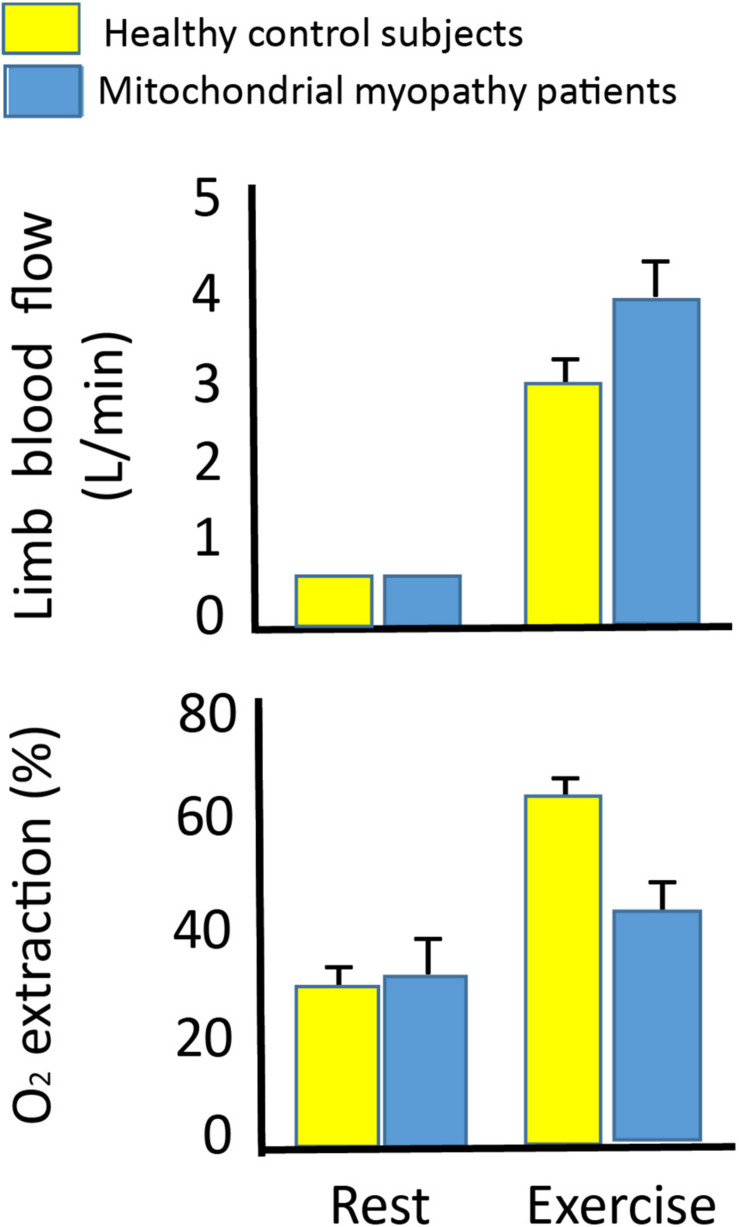
Leg blood flow and oxygen extraction at rest and during leg exercise in 10 patients with mtDNA mutation and 10 healthy subjects. Leg blood flow (upper graph) and oxygen extraction (lower graph) in 10 patients with mtDNA mutation (blue bars) and 10 healthy subjects (yellow bars) at rest and during one-legged knee exercise at maximal workload (27 ± 3 vs. 55 ±6 W). There was a higher leg blood flow in the patients with mtDNA mutation compared to healthy subjects, while oxygen extraction did not change from rest to exercise indicating a hyperemic response to exercise in patients with mtDNA mutation. *Different from healthy subjects (p < 0.05).